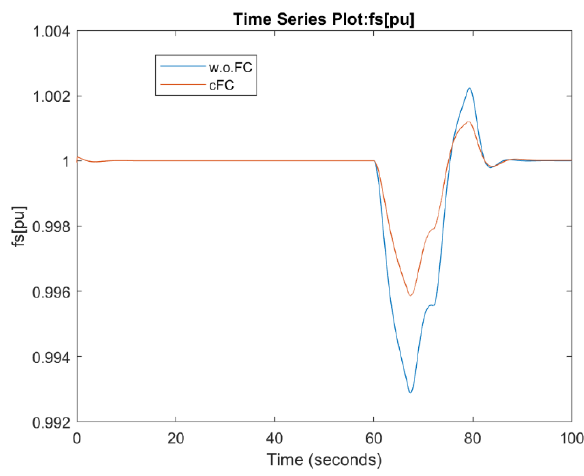
Figure 21. Simulation 8 frequency trend.